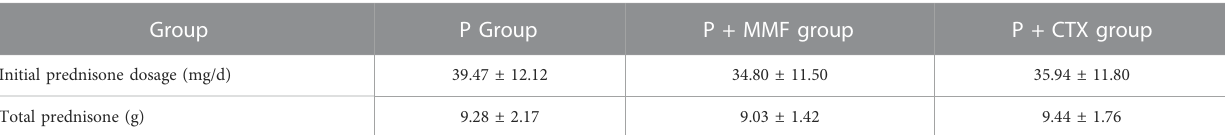
TABLE 2 Prednisone treatment